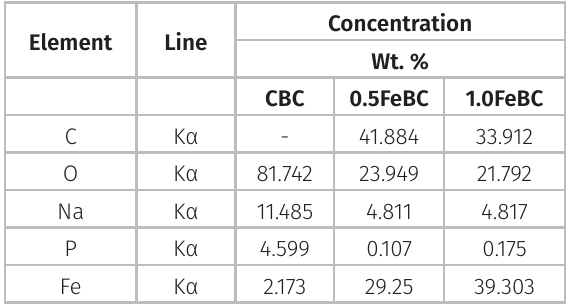
Table II. EDS spectra